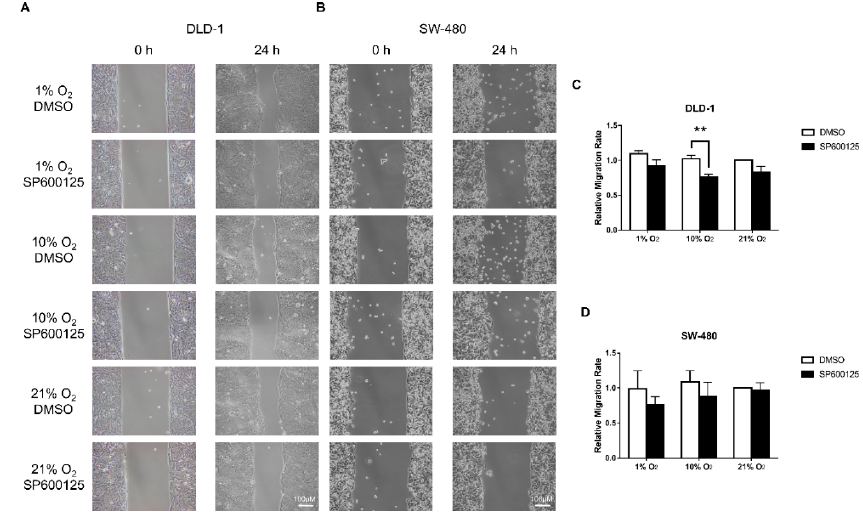
Figure 2. Wound healing assay under di ff erent oxygen levels. Wound healing assay showed that there were no significant di ff erences of migration rate between di ff erent oxygen level incubation in DLD-1 ( A , C ) and SW-480 ( B , D ) cells. While the presence of JNK inhibitor SP600125 (10 µ M) generally reduced the migration rate among di ff erent oxygen levels in both cell lines, with 10% O 2 having significant reduction in DLD-1. The data (means ± SEM) were expressed as the relative migration rate against the rate under 21% O 2 + DMSO ( C , D ). ** p < 0.01, DMSO versus SP600125. N = 3 (SW-480) and 4